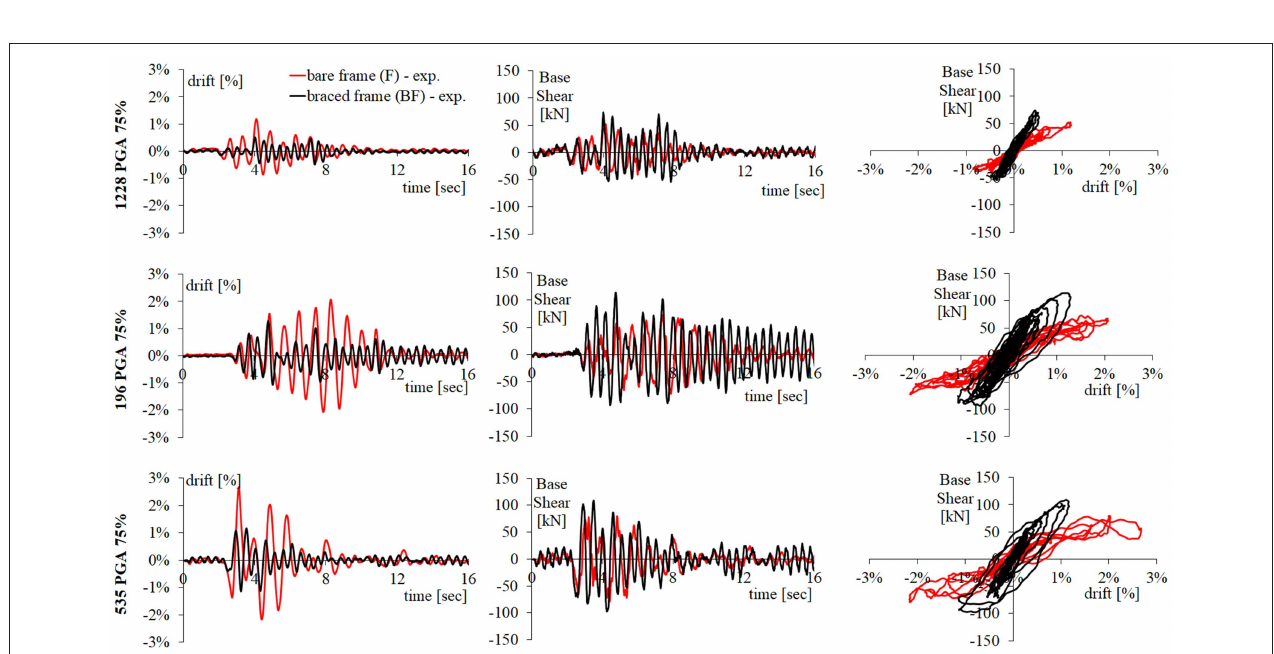
FIGURE 11 | Experimental results for (F) and (BF) obtained for seismic inputs 1228, 196, and 535 at 75% of PGA: time-histories of base shear and total drift and base shear vs. total drift.